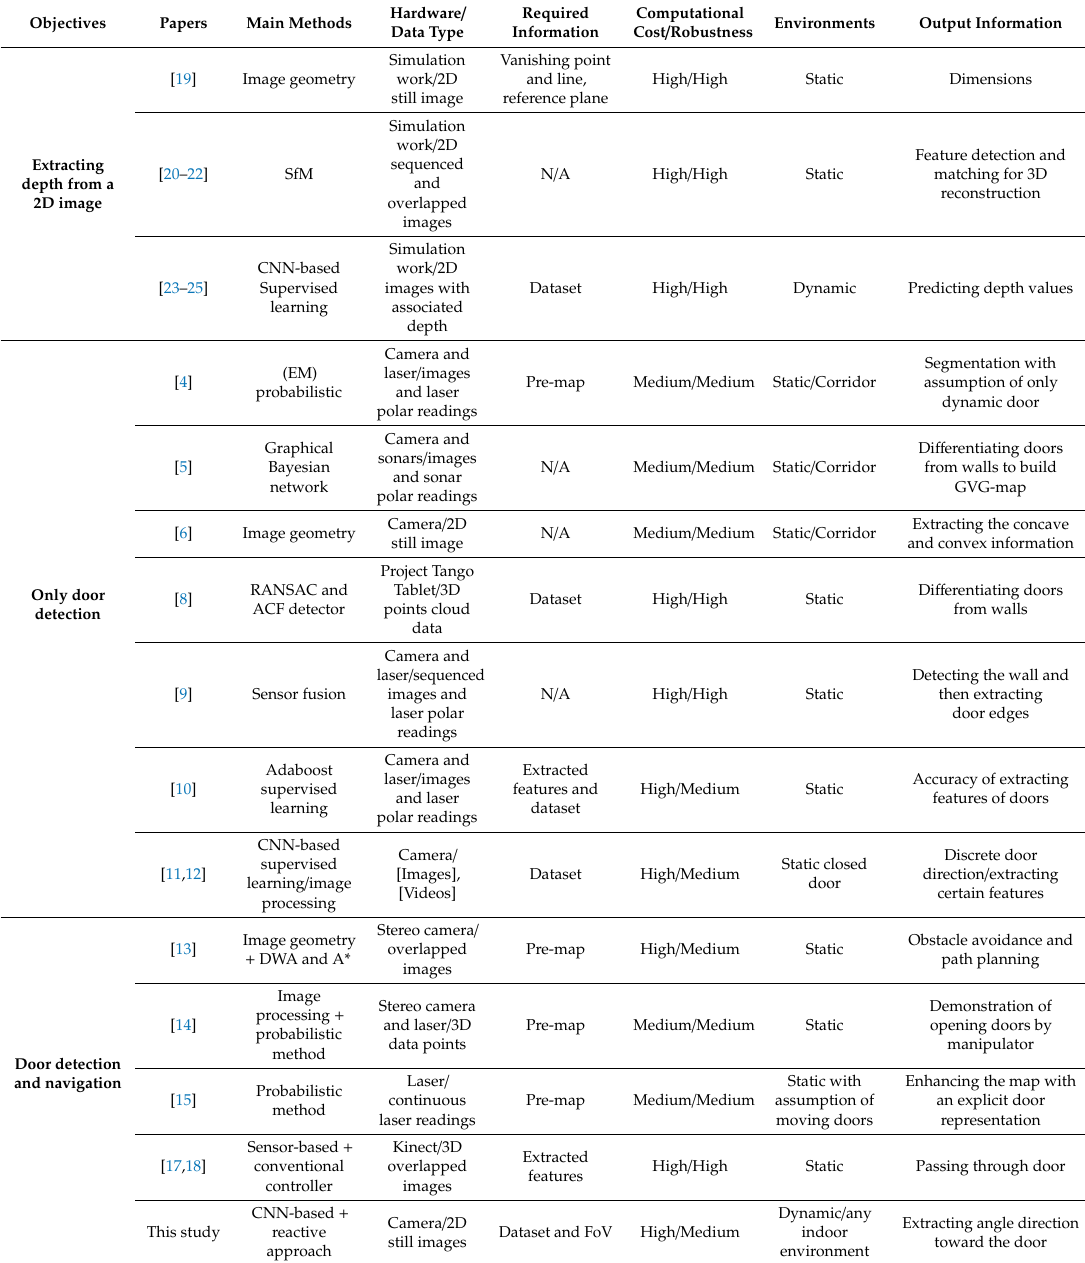
Table 5. Qualitative comparison of related